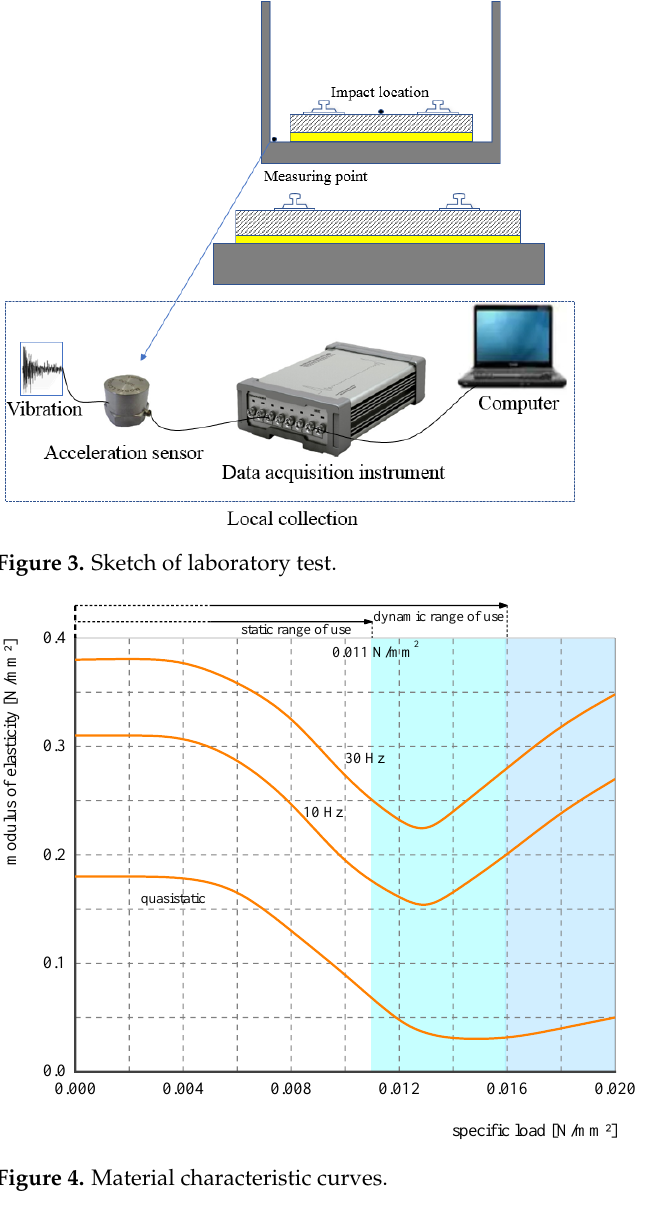
Figure 4. Material characteristic curves .